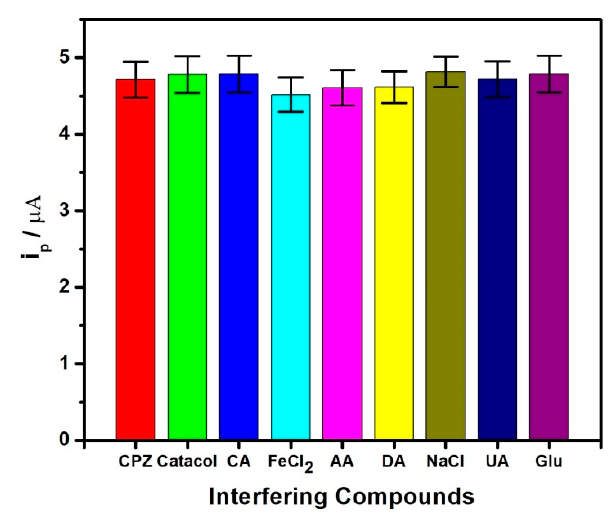
Figure 7. Comparison of the peak current of CPZ in the presence of interfering compounds at at N-CDs / Cu 2 O / Nf / GCE (CA: Ca ff eic Acid; AA: Ascorbic acid; DA: Dopamine; UA: Uric acid; N-CDs/Cu 2 O/Nf/GCE (CA: Caffeic Acid; AA: Ascorbic acid; DA: Dopamine; UA: Uric acid; Glu: Glu: Glucose).